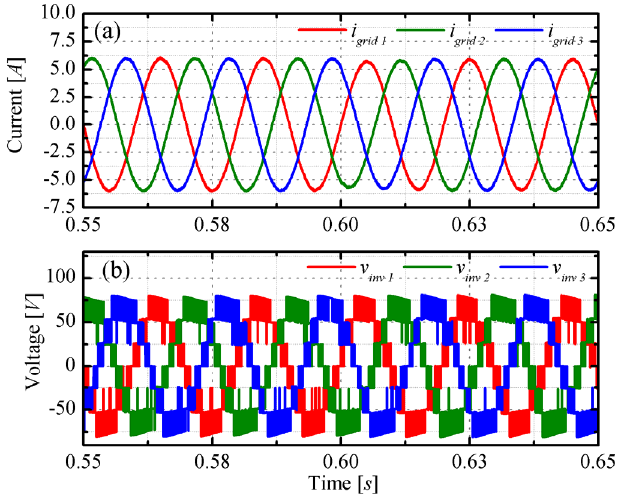
Figure 13. Dynamic partial shading: comparison among ( a ) phase currents i grid,p ; and ( b ) phase modulated voltages v inv,p .